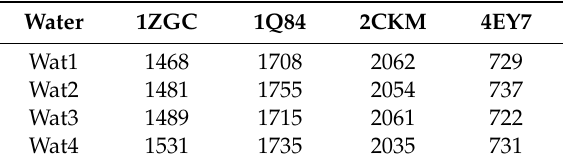
Table 4. Conserved waters considered in the docking experiments.